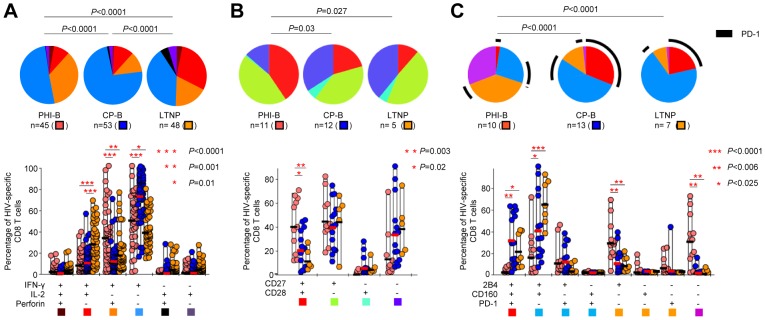
Functional profile and expression of co-stimulatory molecules and of co-inhibitory receptors of HIV-specific CD8 T-cell responses during acute and chronic HIV infections.Analysis of the functional profile (A), of the expression of CD27 and CD28 (B) and of the expression of 2B4, CD160 and PD-1 (C) in HIV-specific CD8 T cells in patients with acute (PHI-B), untreated chronic progressive (CP-B) or non-progressive (LTNP) HIV infection. Representative examples of the distinct flow cytometry panels are shown in Fig. S1B-D. Regarding the functional profile (A), although TNF-α was detected, analyses are restricted to the expression of IFN-γ, IL-2 and perforin for clarity. All possible combinations of the distinct markers are shown on the x axis, whereas the percentages of the distinct cell subsets within virus-specific CD8 T cells are shown on the y axis. The pie charts summarize the data, and each slice corresponds to a certain combination of molecules. Colors in the pie charts are based on the colored boxes at the bottom of the panel.